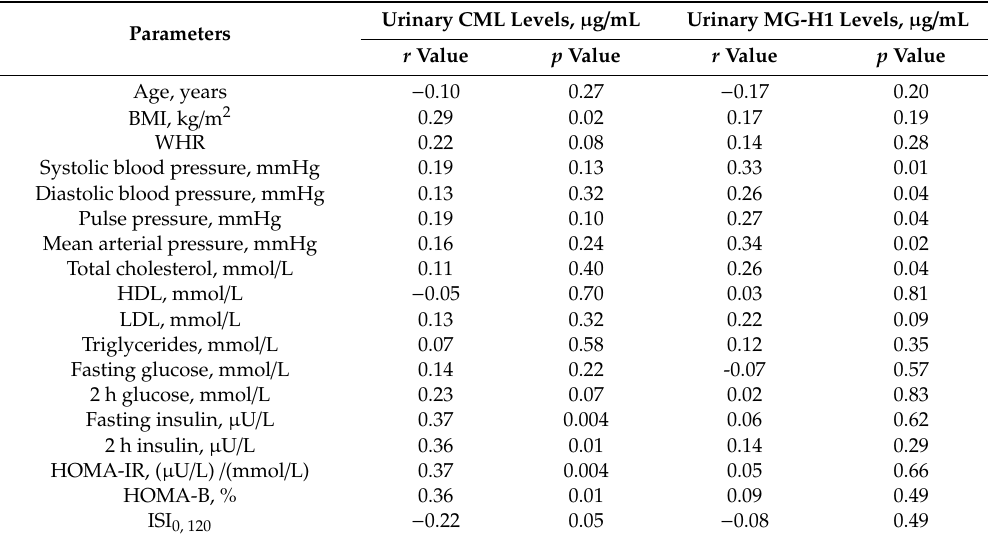
Table 2. Univariable analyses between advanced glycation end products (AGE) levels and cardiometabolic